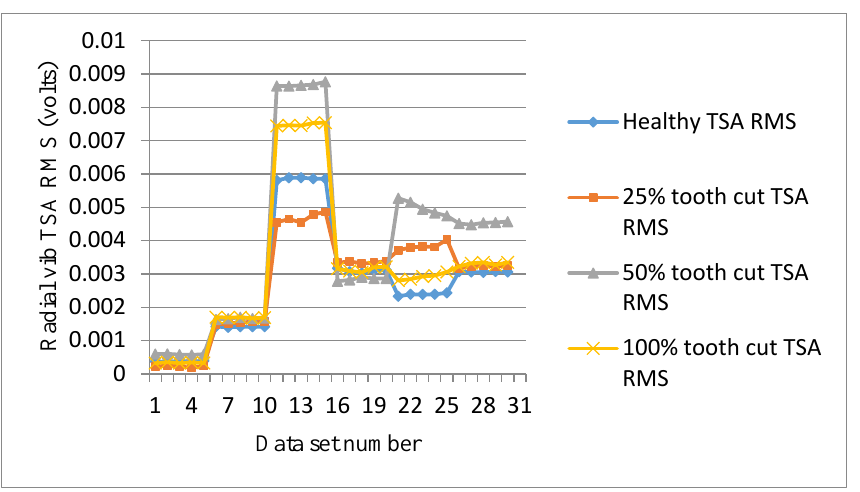
Figure 15. RMS of radial vibration TSA